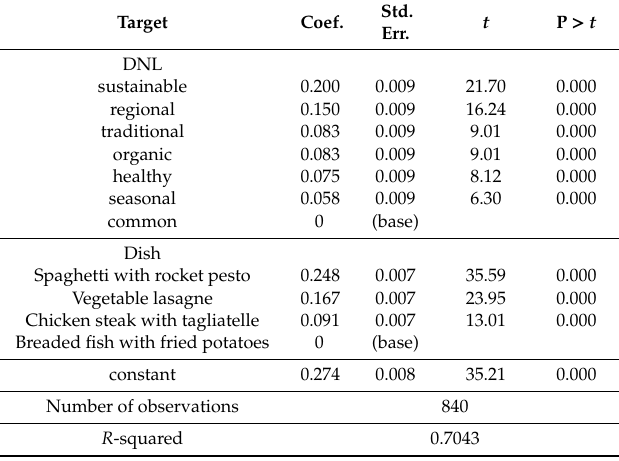
Table 7. Linear Regression (DV: Target dish selection, IV: DNL variant, Dish variant).